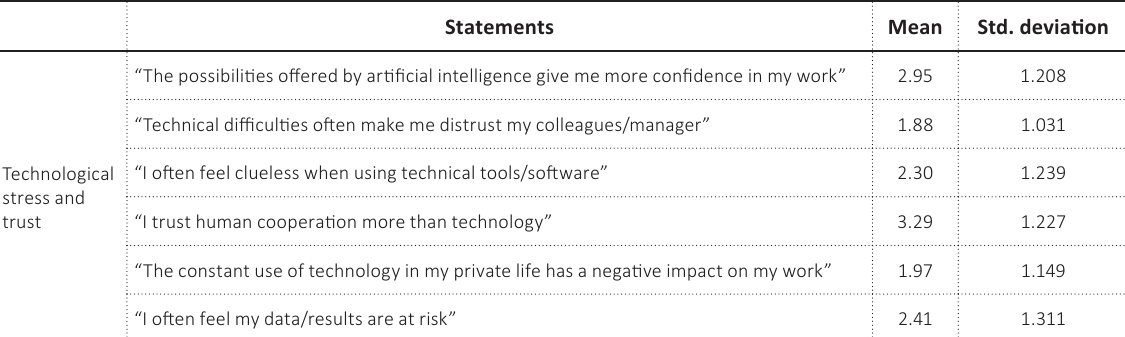
Table 6. Relationship between technological stress and